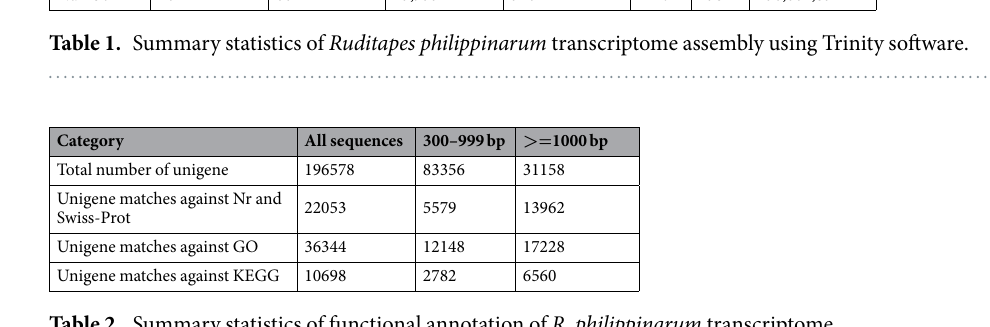
Table 2. Summary statistics of functional annotation of R. philippinarum